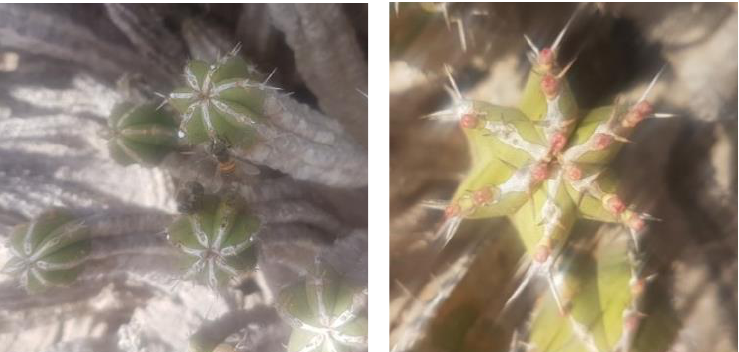
Figure 1. Euphorbia officinarum L. in Moroccan fields.